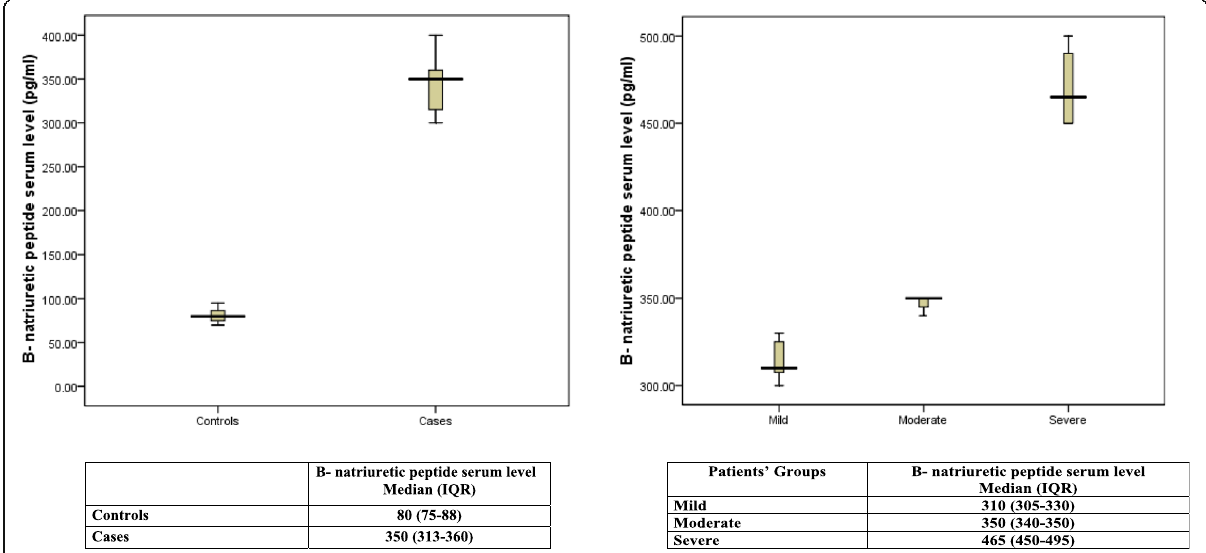
Fig. 1 Comparisons of serum B-natriuretic peptide (BNP) levels among patients and controls. a Serum BNP levels were significantly higher in patients before administration of treatment compared to controls. b Cases that showed mild disease severity had lower BNP serum levels compared to moderate patients, while moderate patients showed decreased levels in comparison to severe